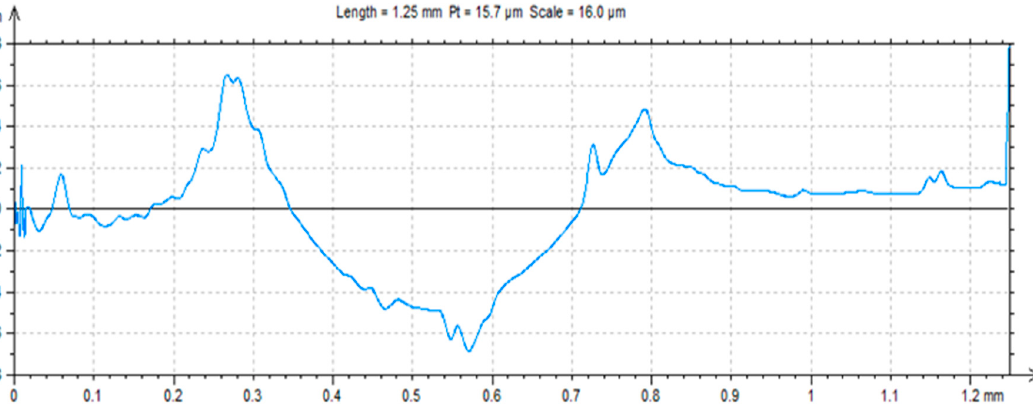
Figure 13. Trace after ball-on-plate test for pure copper.